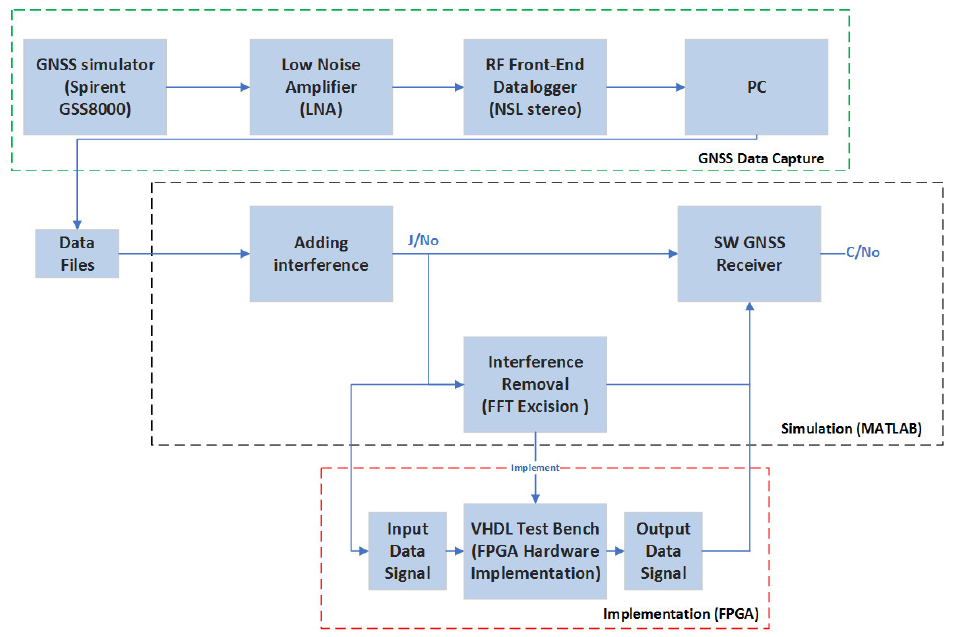
Figure 3. Operational scheme of the proposed methodology .